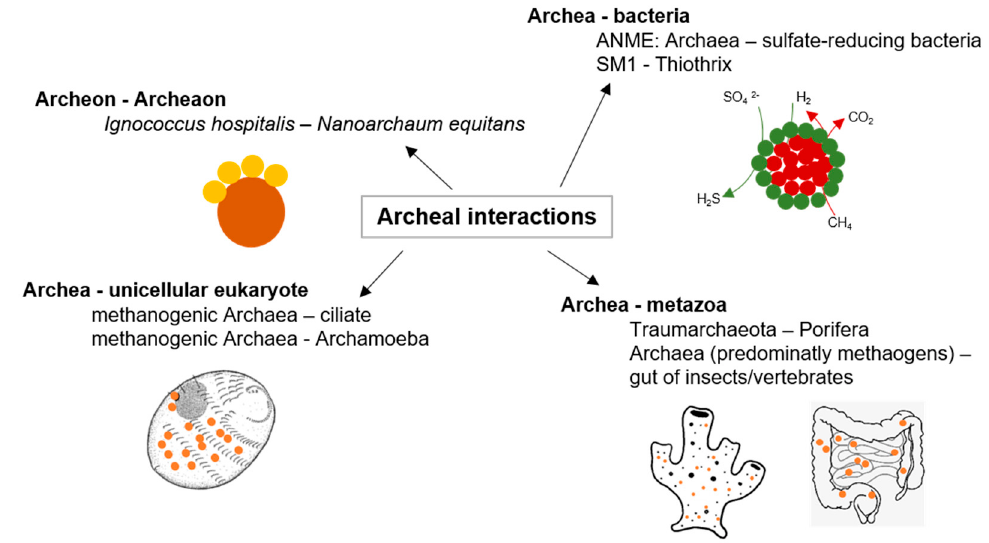
Figure 2. Archaeal interactions; examples of archaeal interactions adapted from [38].